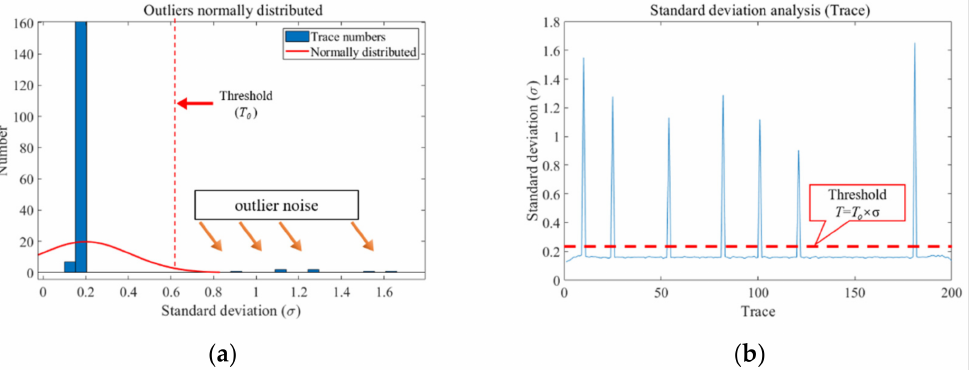
Figure 4. The statistical results of outlier noise for the data in Figure 3b. ( a ) Energy distributed analysis. ( b ) Threshold processing